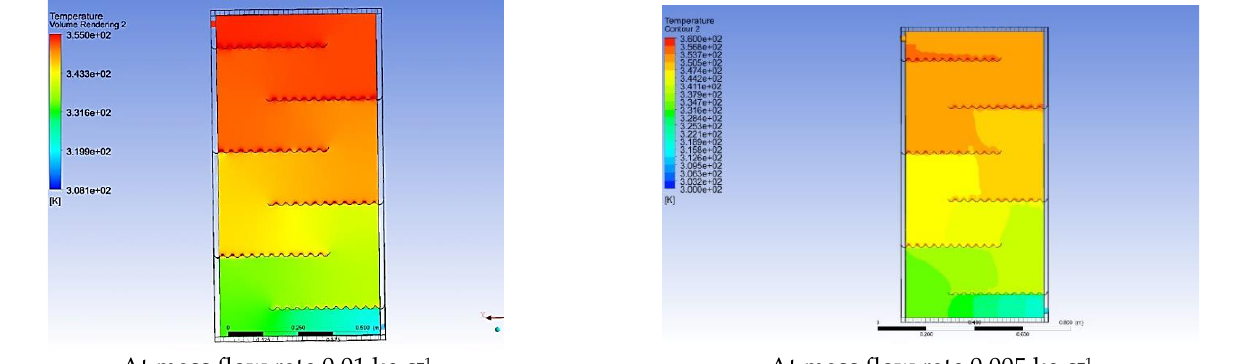
Figure 4. Performance prediction of air temperature distribution pattern using CFD for the SAH (e x = 10 x ).